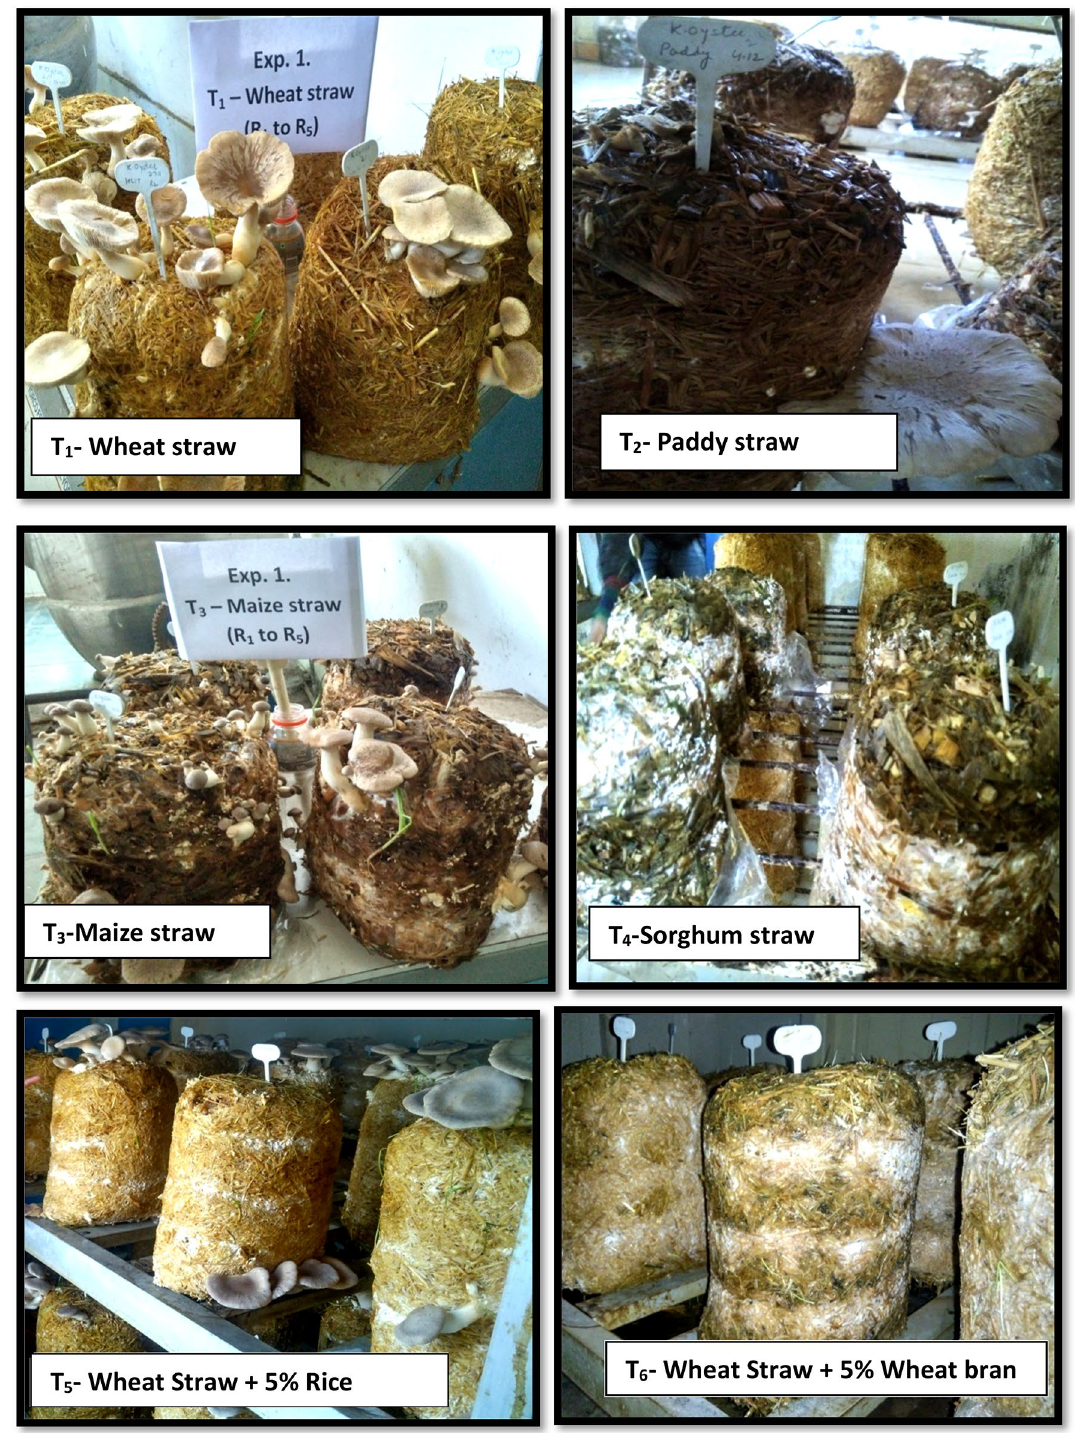
Figure 1. Photographsof different substrates and supplements used for P. eryngii